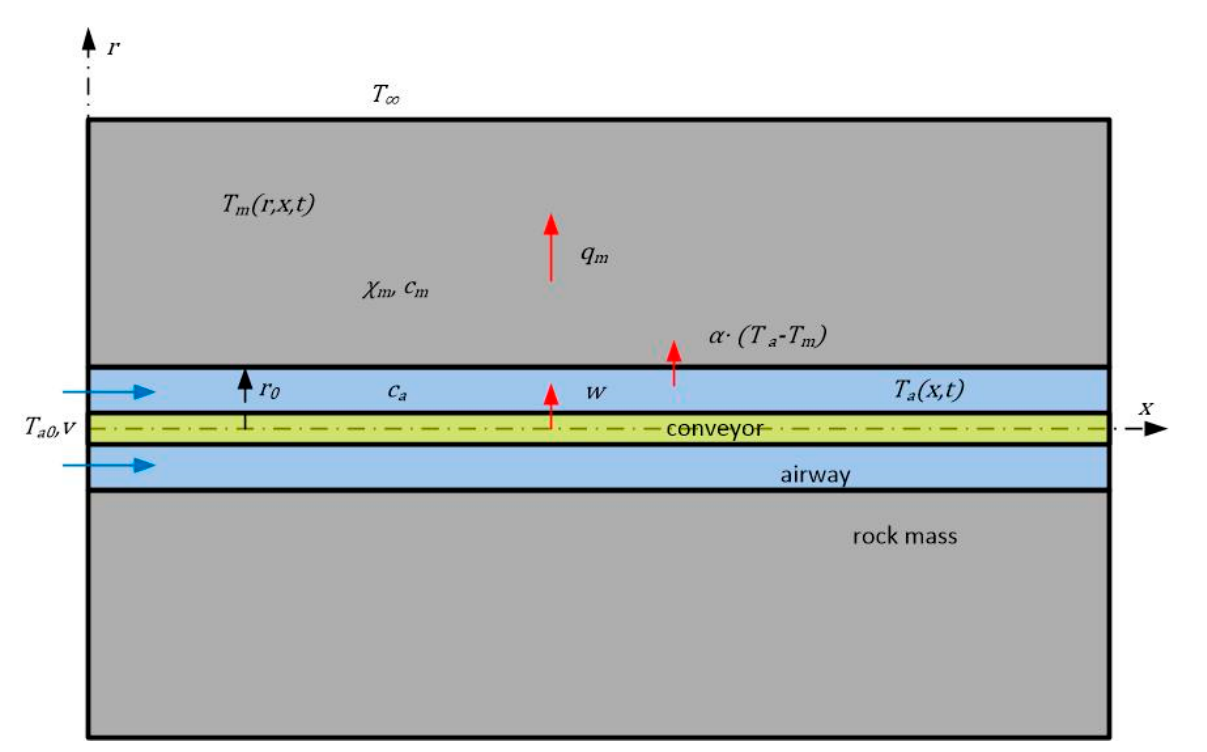
Figure 2. Computational scheme.